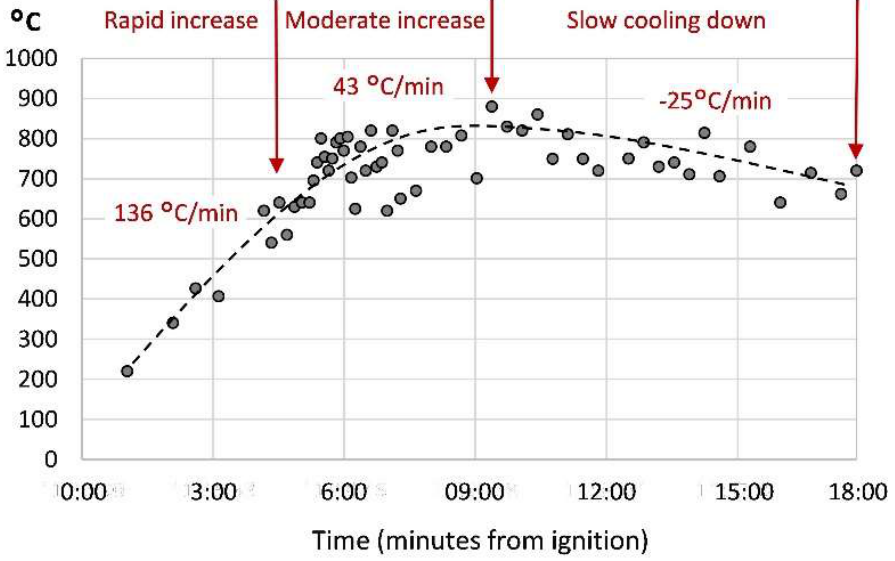
Figure 4. Ground temperatures during the burning experiment. At 2 min from the ignition, the temperature was 400 °C; 5 min from the ignition, the recorded temperature reached ~700 °C; peak temperature (880 °C) was reached after 9 min, following which temperatures started to reduce. Temperature gradients calculated per minute (°C/min) in red.